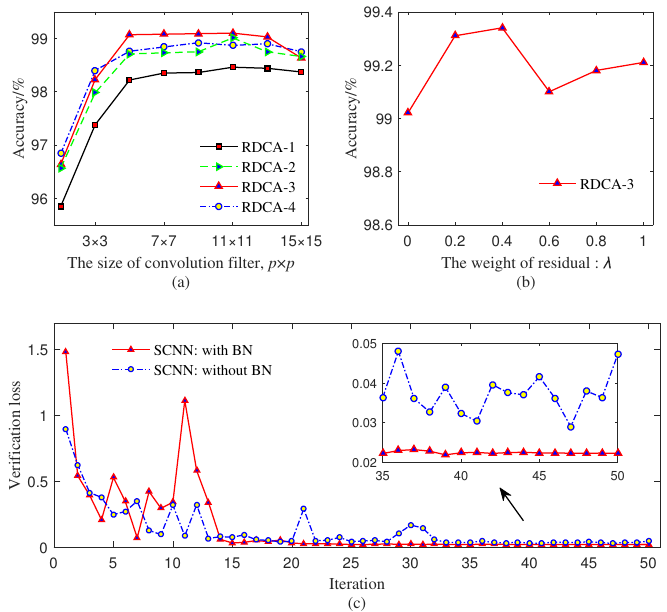
Figure 9. The classification accuracies and loss curve, where the RDCA- i denotes the RDCA has i layers convolution and max-pooling. ( a ) Accuracy with different layers and filter sizes when λ = 0, ( b ) accuracy with different λ , ( c ) verification loss of SCNN with and without BN